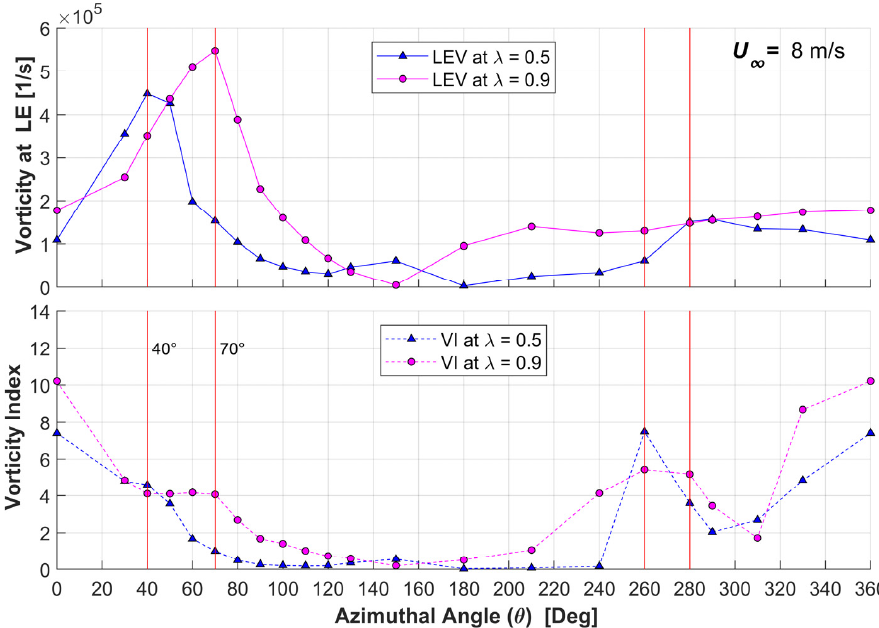
Figure 17. LE Vorticity and VI Values for Blade 1 at Various Azimuthal Angles for 𝑈 (cid:2998) = 8 m/s at 𝜆 =0.5 and 𝜆 =0.9.